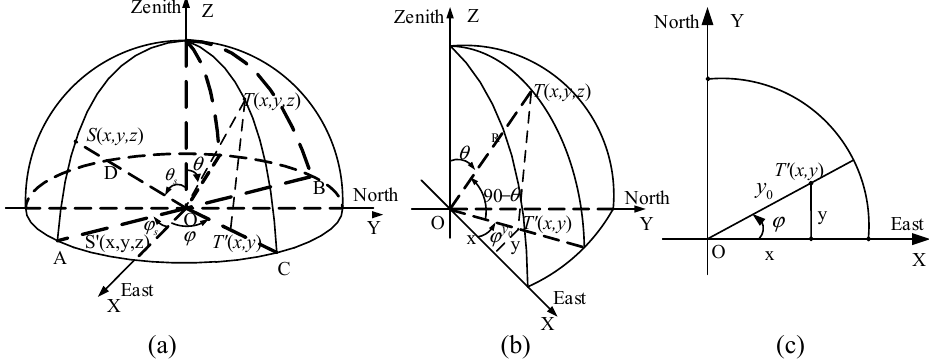
Figure 6. Theoretical skylight polarization pattern coordinate representation and imaging relationship. ( a ) The three-dimensional (3D) coordinate representation of skylight polarization pattern; ( b ) the meridian section of the celestial sphere; ( c ) the imaging relationship of skylight polarization pattern.